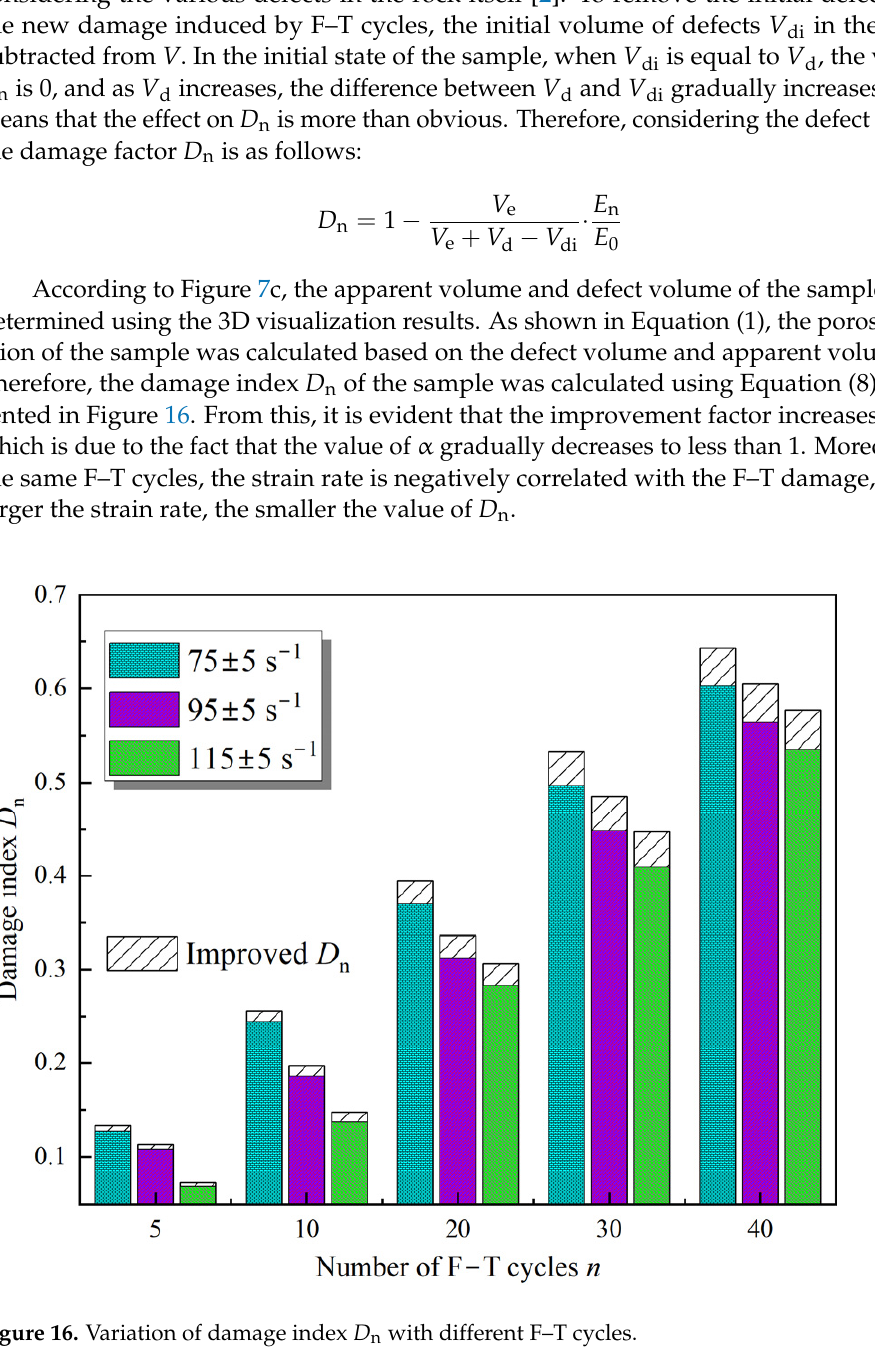
n with different F–T